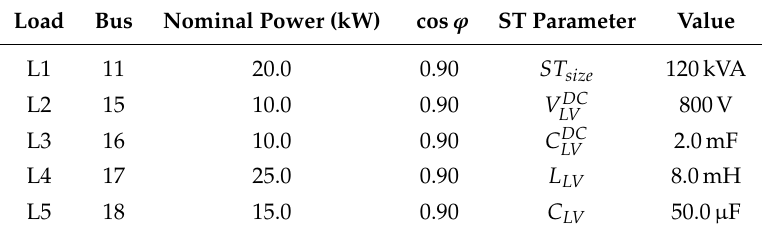
Table 1. Load and ST (smart transformer)